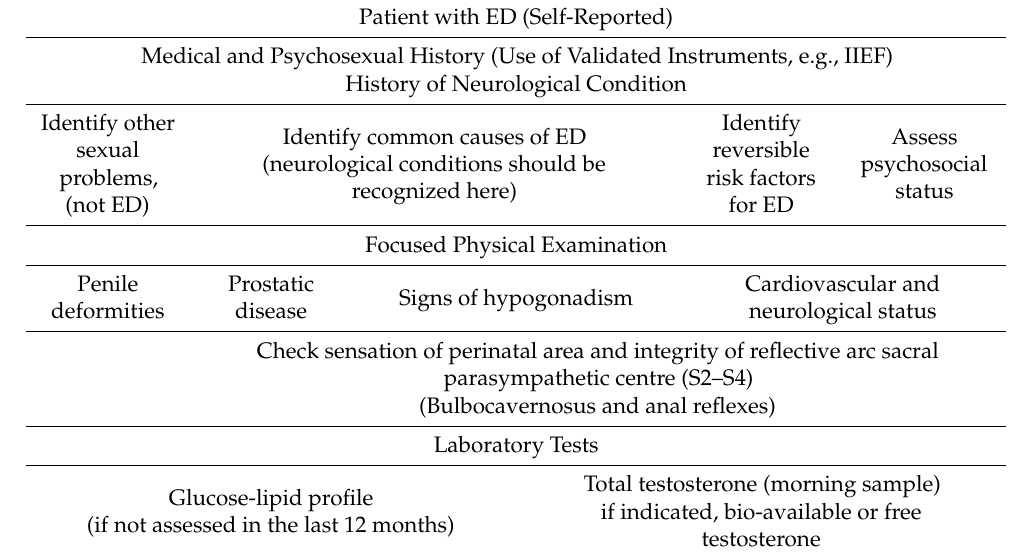
Table 2. Minimal diagnostic evaluation in patients with ED (including neurogenic ED). Adapted from EAU Guidelines on Sexual and Reproductive Health 2020